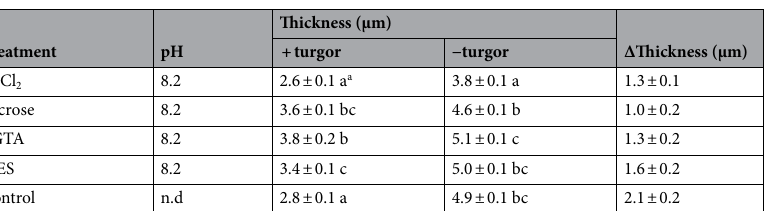
Table 7. Thickness of anticlinal cell walls of excised skin segments (ES) of ʻ Burlat ʼ sweet cherry fruit after pretreating whole fruits by incubation for 24 h in isotonic CaCl 2 solution containing 10 mM MES, isotonic sucrose solutions without CaCl 2 or in hypotonic 5 mM EGTA containing 10 mM MES or 10 mM MES buffer only. Thickness of cell walls was determined on ES after excision and pretreating intact fruit for 24 h (+ turgor). The turgor was then released by a freeze/thaw cycle (−turgor). After 48 h, the cell wall thickness was again measured. Fruits for control were held for 24 h at room temperature. Swelling (Δthickness) was calculated as the difference in cell wall thickness without turgor, minus that with turgor. Data are means ± SE. n.d. not determined. a Mean separation within columns, Tukey’s Studentized range test at p < 0.05.